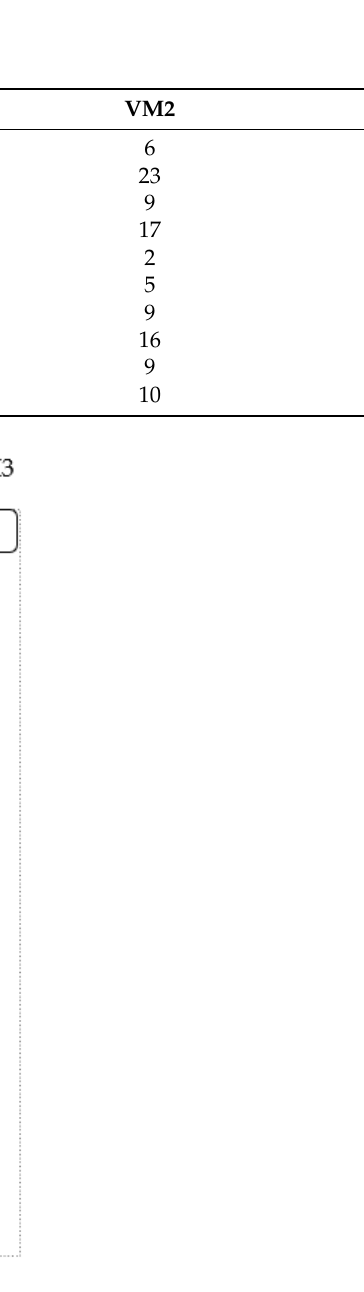
Figure 4. Scheduling of DAG with original HEFT algorithm (use of average computation cost in rank calculation). The schedule length is 98.